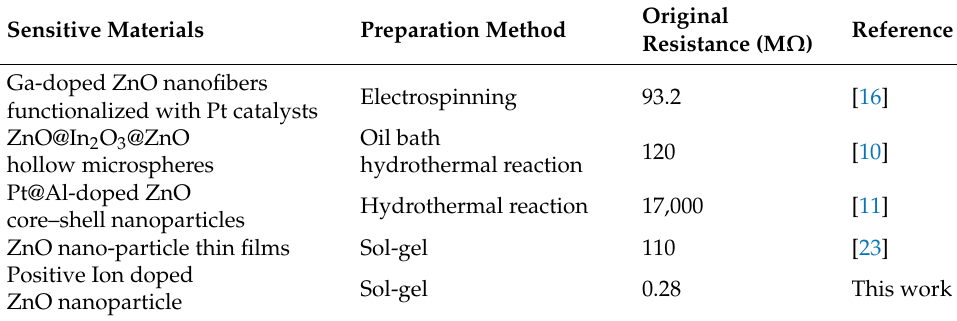
Figure 3. XPS spectra: ( a ) Al 2s of Al0.5-ZnO, ( b ) Sn 3d of Sn0.5-ZnO, and ( c ) Sb 3d of Sb0.5-ZnO. O 1s of ( d ) Al0.5-ZnO, ( e ) Sn0.5-ZnO, ( f ) Sb0.5-ZnO, and ( g ) ZnO. Table 1. Comparison of resistance values of different